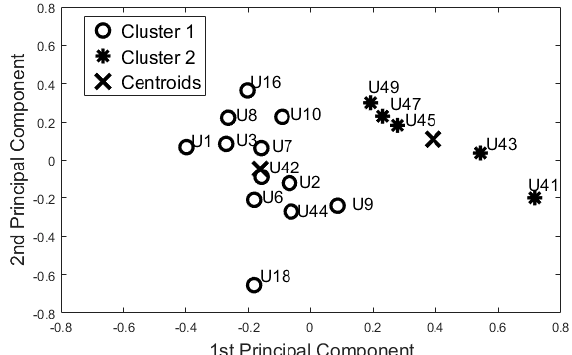
Figure 4. Night-time Period - Cluster Analysis and K-Means (KM) Centroids obtained with the Training Dataset